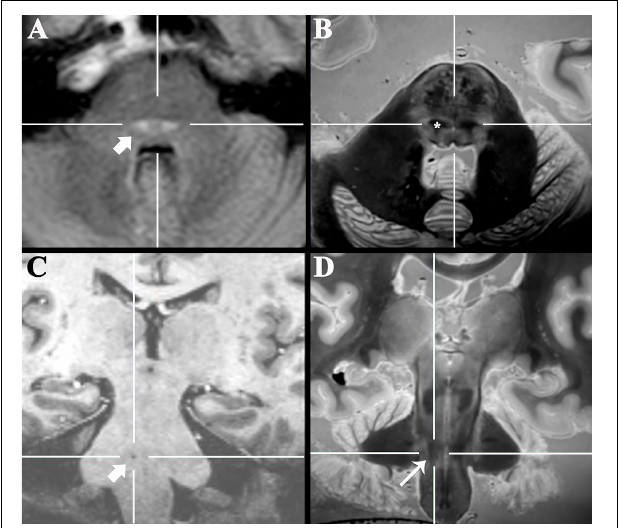
FIGURE 5 | Axial 3-T FLAIR clinical image of a 47-year-old patient with new sensory loss and suspected Multiple Sclerosis (A) demonstrated new bilateral FLAIR-bright demyelinating lesions in the pons (arrow). Coregistered 3D SPACE ex vivo image (B) suggested the lesions were in the medial lemniscus (*, labeled unilaterally). Oblique coronal 7-T 3D T1-weighted image (C) of a 77-year-old patient that presented with progressive dysarthria, palatal myoclonus and hypertrophic olivary degeneration (not shown). The precise anatomic location of a tiny T1-dark lacunar infarct in the right pons (arrow) could not be determined even with 7-T MRI. Coregistered 3D SPACE ex vivo image at 3-T (D) suggests the lesion is in the central tegmental tract (long